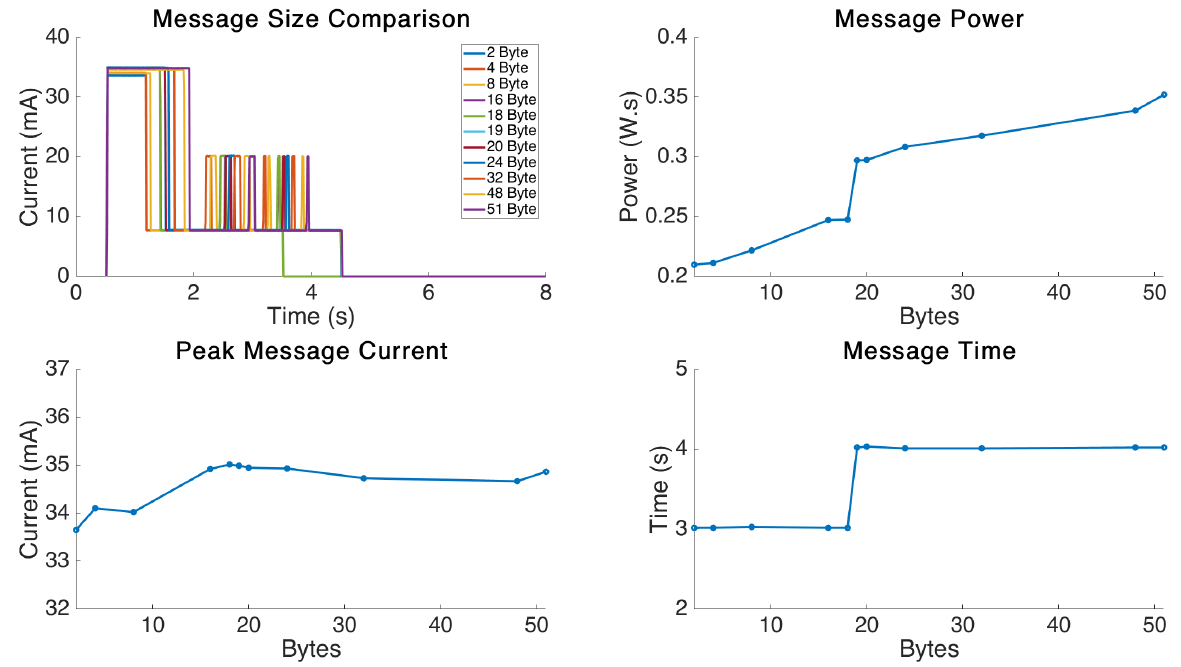
Figure 6. Message size